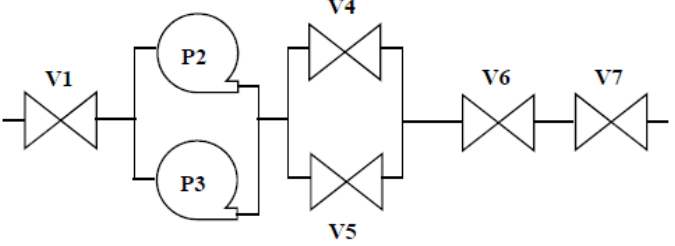
Figure 2. Real fluid injection system adopted from [11]. Other